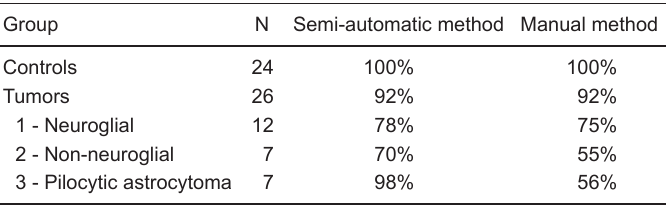
Table 4. Classification accuracy for different tumor types, and for normal versus tumoral tissue.